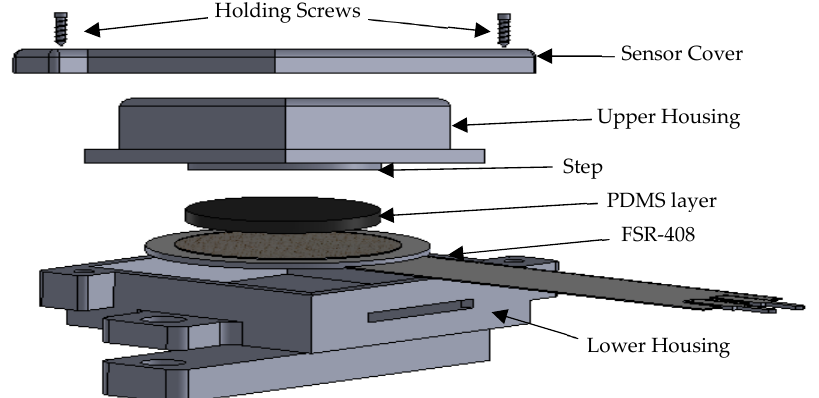
Figure 1. Exploded view of FSR sensor with housing.